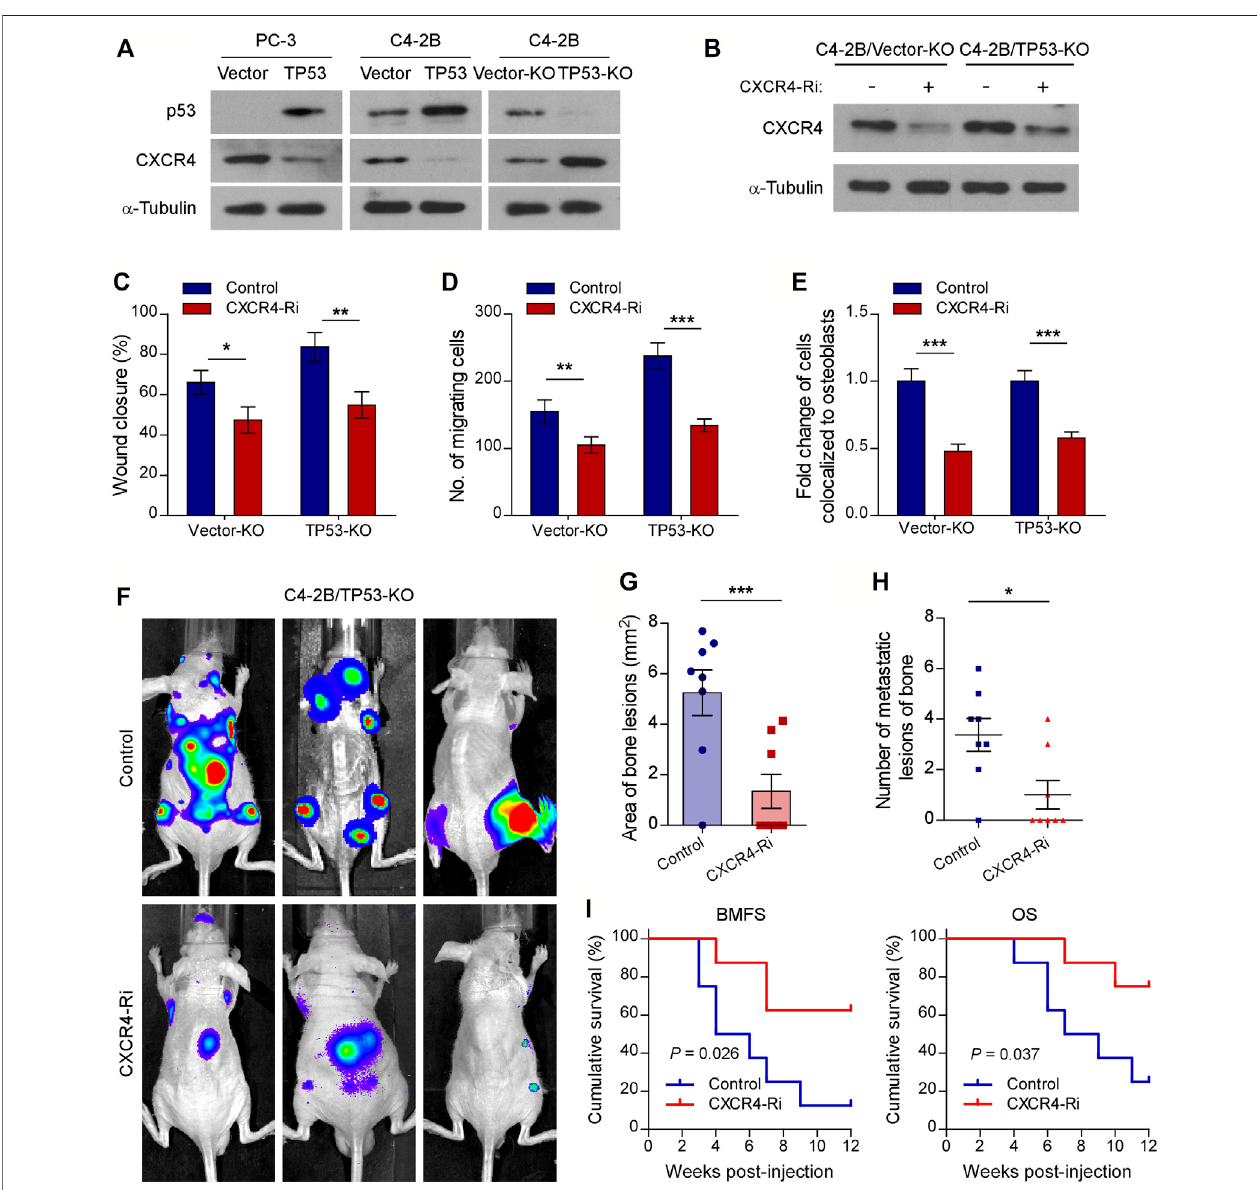
FIGURE 3 | Chemokine receptor CXCR4 is functionally essential target of wt-p53 in prostate cancer bone metastasis. (A, B) Western blot analysis of CXCR4 expression in the indicated cells. α -Tubulin served as a loading control. (C) Wound-healing assays for the indicated cell lines. Wound closure was photographed at 24 h after wounding. Tumor cells were cultured in MC3T3-E1 condition medium. (D) Quanti fi cation of the migration of indicated cells in transwell assays. Tumor cells (top chamber) were co-cultured with primary osteoblasts (bottom chamber) in the transwell plate. (E) Quanti fi cation of in vitro competitive colocalization assays for the indicatedcells.Errorbars represent themeans ± SD. (F) RepresentativeBLIimages ofbone lesionsfrom miceintracardiallyinoculatedwithprostatecancercellsineach experimental group ( n (cid:1) 8/group). (G) Histomorphometric quanti fi cation of tumor area in hind limbs from each experimental group. (H) Numbers of metastatic lesions in hind limb bones from each mouse in two groups. Error bars represent the means ± SEM. (I) Kaplan-Meier curves of bone metastasis-free survival (BMFS) and overall survival (OS) in mice from each experimental group (log-rank test). P values were based on t -test unless otherwise indicated. * p < 0.05, ** p < 0.01, *** p < 0.001.